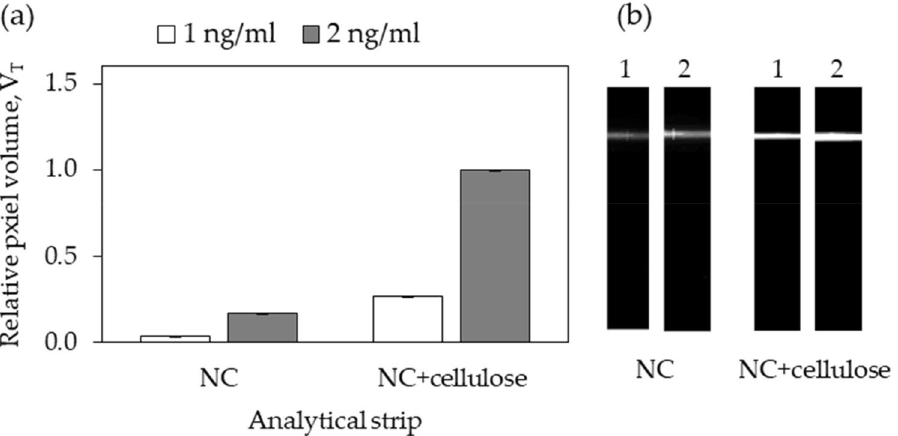
Figure 3. Impact of coating cellulose over NC strips on the fluorescence of signals generated. Lines of biotin- BSA were dispensed on NC and NC + cellulose strips. Following assembly, buffer samples containing either 1 ng/mL or 2 ng/mL of Alexa-labeled streptavidin were run on the cartridges. ( a ) The pixel volume of the lines, V T , was obtained and normalized relatively to the highest pixel volume obtained in all experiments. ( b ) Representative black and white fluorescence images of lines in the analytical strips as captured by the ImageQuant camera. Experiments were performed in